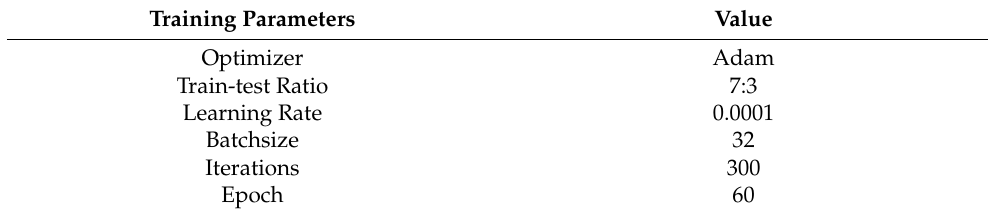
Table 3. Training parameters of three CNN.